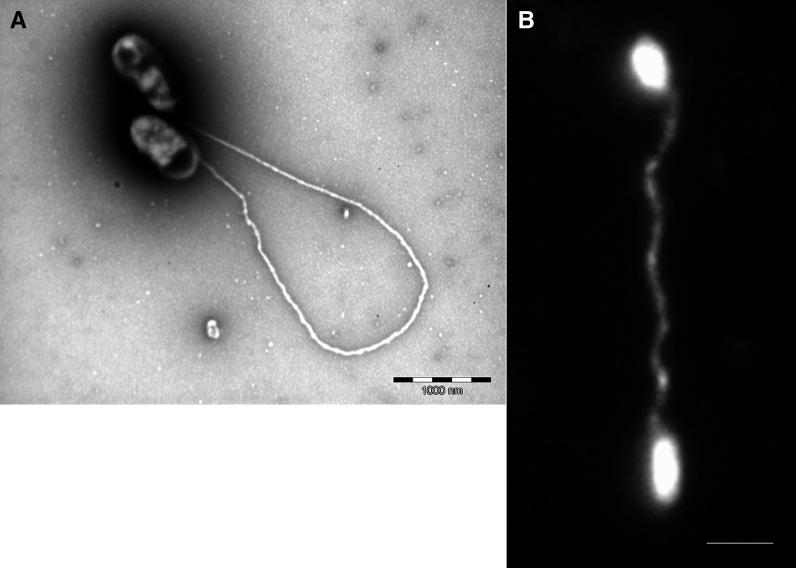
Sex Pili-Like Surface Appendage of R. bellii
(A) Electron micrograph of pili observed after negative staining. R. bellii shows long and flexible pilus between 2 bacteria observed from supernatant of XTC-2 cells infected for 48 h at 28 °C. Bacteria were fixed by addition (1:1) of 2% formaldehyde-saline and samples were applied to copper Formvar grids (Electron Microscopy Sciences) for 2 min before negative staining with 1% phosphotungstic acid (pH 6.5) for 2 to 4 min. Samples were examined with a Hitachi 7000 transmission electron microscope.(B) Immunofluorescence performed on the same bacterial culture. R. bellii were probed with a rabbit polyclonal anti-R. belli antibody and with a FITC-conjugated goat anti rabbit Ig as secondary antibody. Slides were examined with an Olympus BX 51 microscope (magnification 100×).